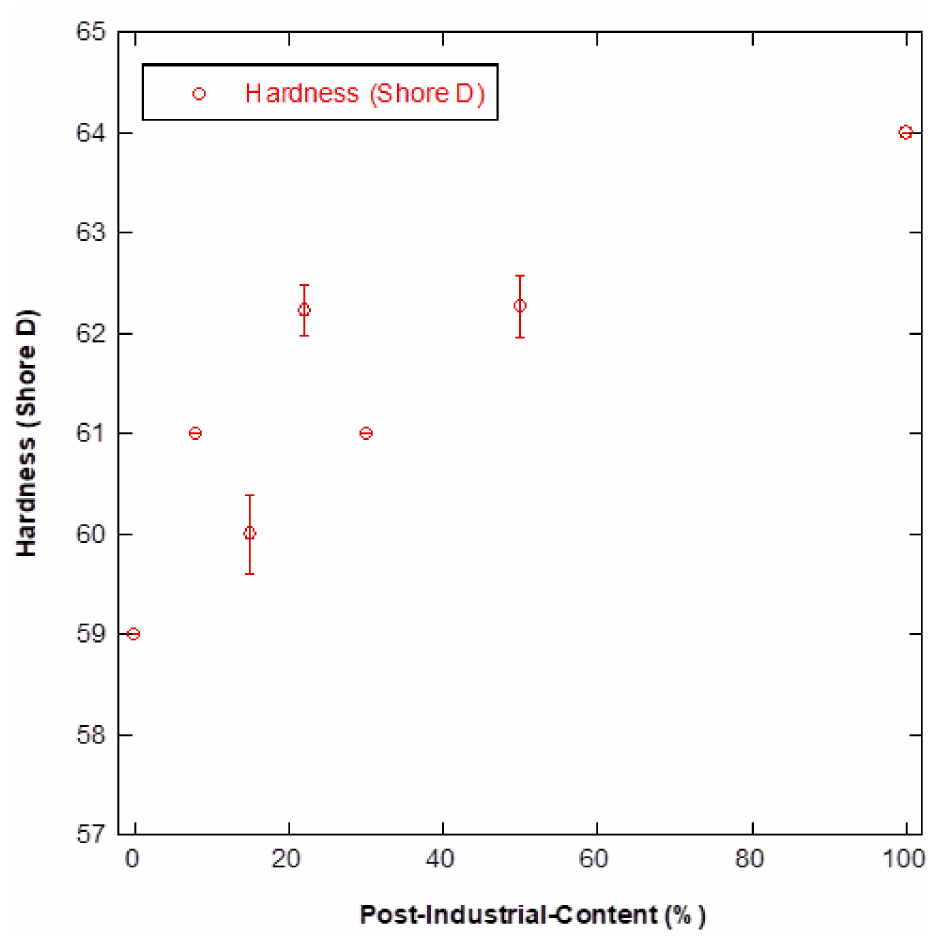
Figure 12. Trend for Shore hardness versus post-industrial